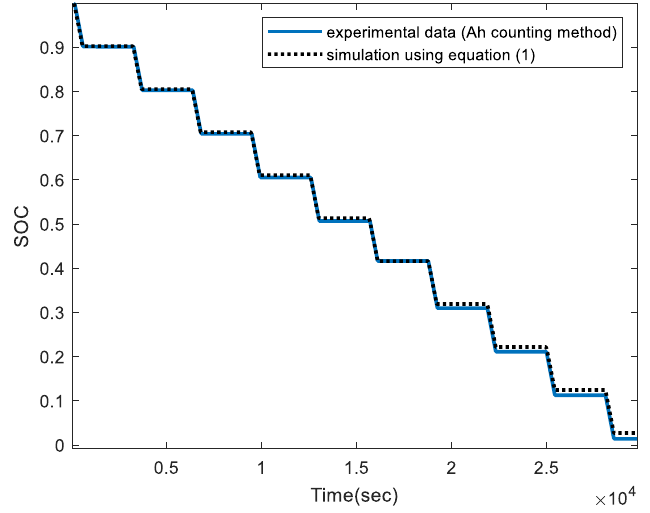
Figure 6. State-of-charge during discharging pulse test at 25 °C.